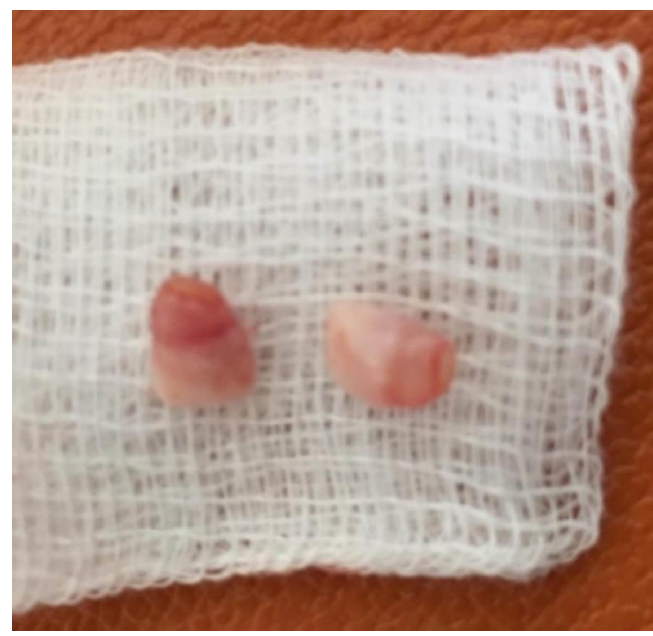
Figure 2. Extracted natal teeth.